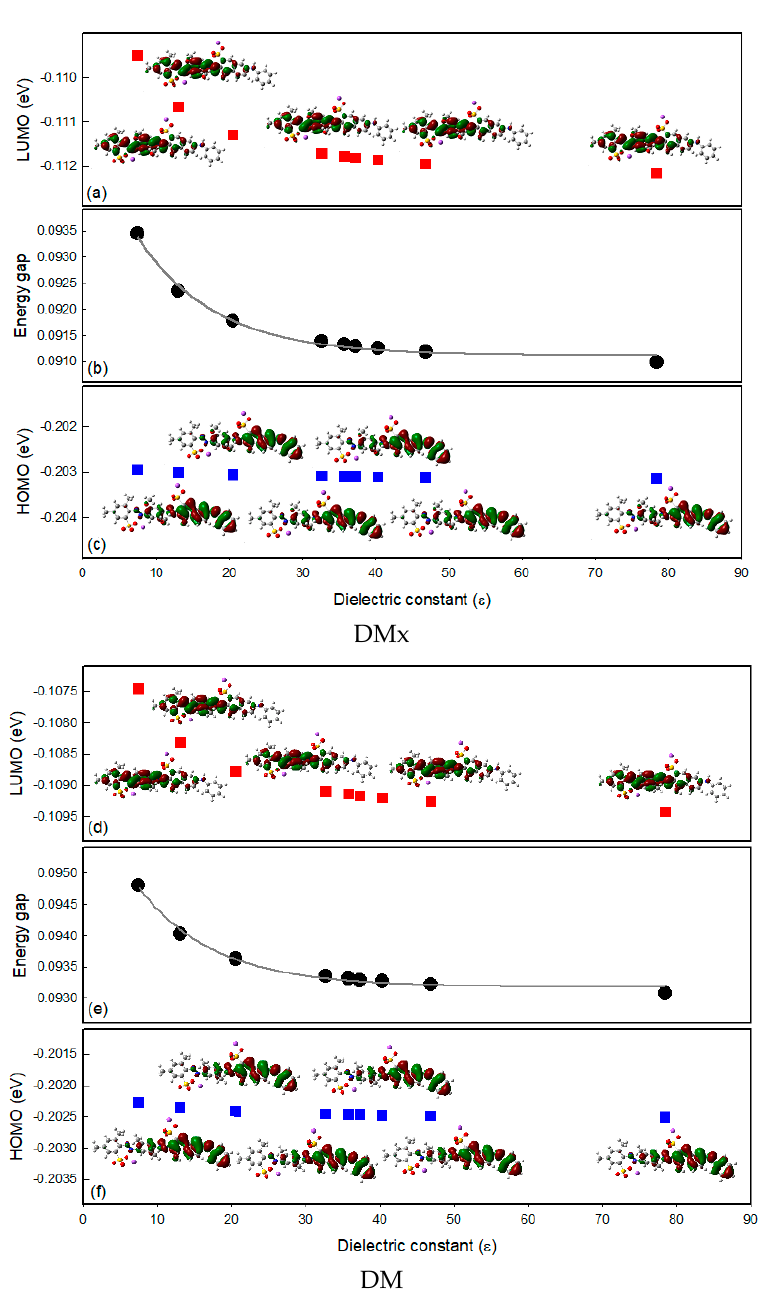
Figure 8. ( a , c , d , f ) Molecular orbital energy diagrams and isodensity surface plots of DMx and DM; ( b , e ) molecular orbital energy gap tendency for solvent dielectric constants.